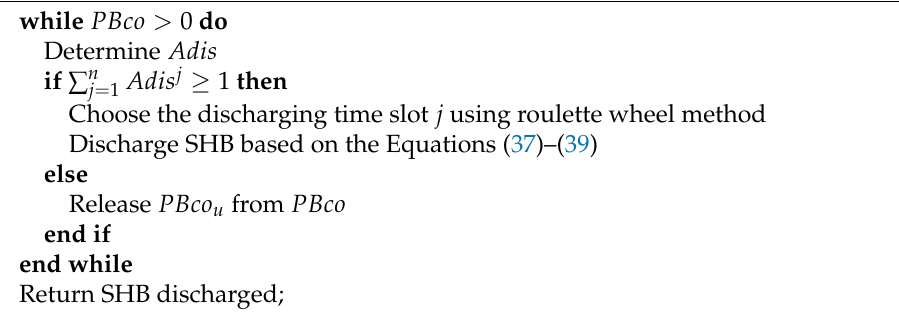
Algorithm 4 Pseudocode of discharge the SHB